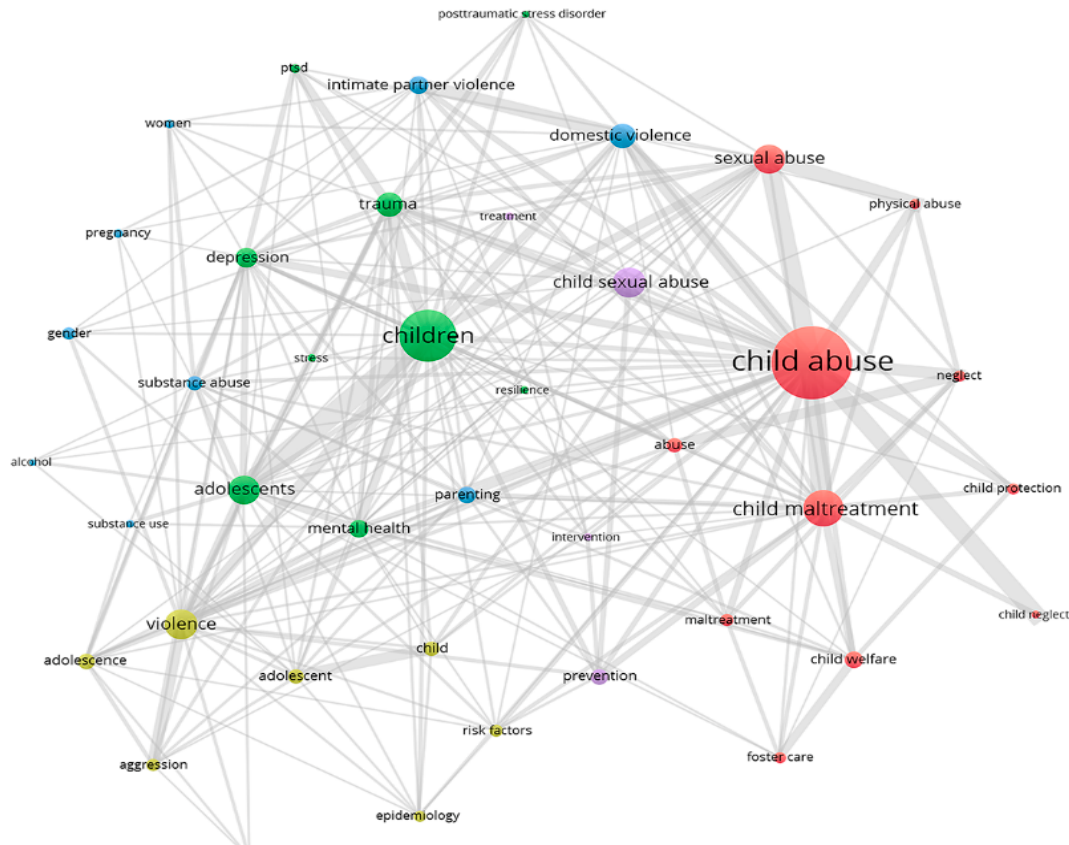
Figure 3. The most frequent keywords. Int. J. Environ. Res. Public Health 2018 , 15 , x